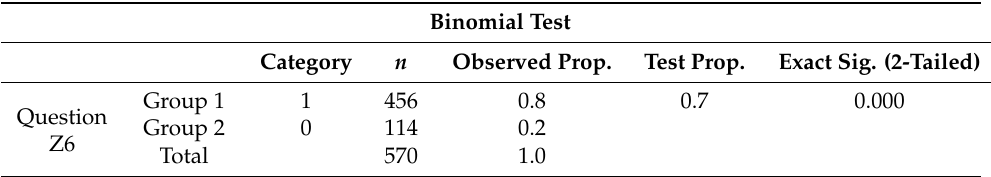
Table 5. Results of the binomial test to the Hypothesis H1—customers.